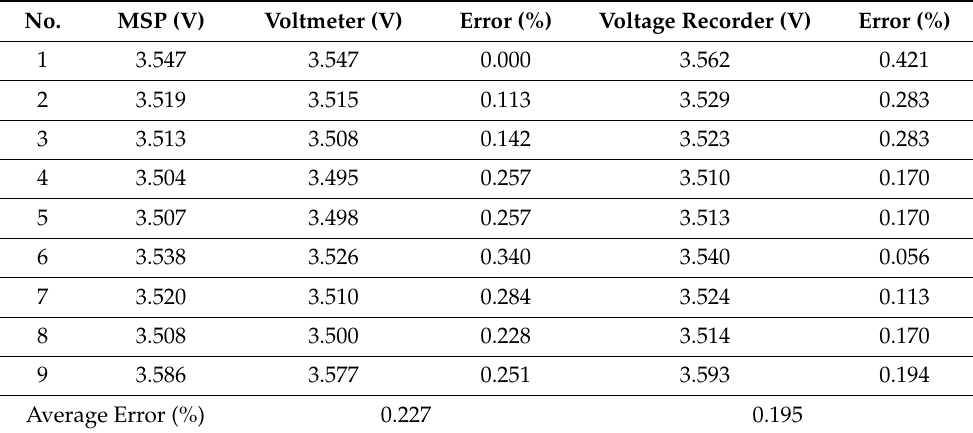
Table 1. Errors comparisons of voltage